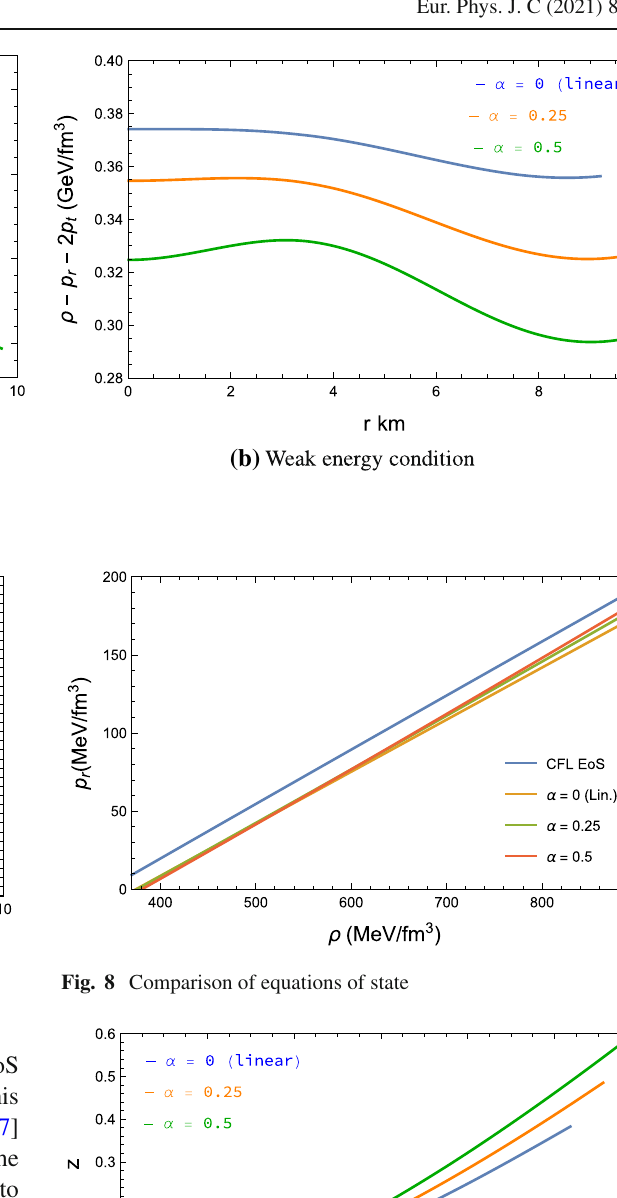
quadratic term in achieving the higher densities and pressures while maintaining stability of the core. Pressure anisotropy is a key feature of our models and the anisotropy parameter dis- played radial profiles which were favourable and comparable to other studies. The Vaidya–Tikekar potential used, with the spheroidal parameter ( K = − 5 ) used, resulted in the pos- sibility of an additional inhomogeneity as suggested by the minima in the tangential sound speed profiles. According